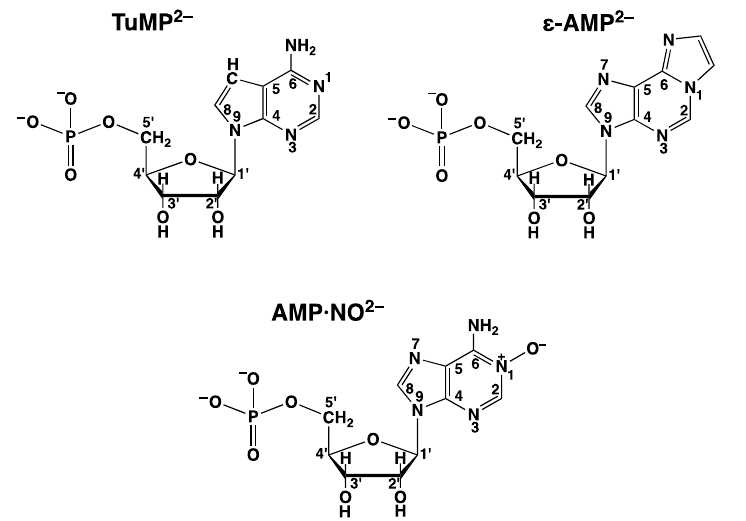
Figure 12. Chemical structures of AMP 2 − analogues: tubercidin 5 ′ -monophosphate (TuMP 2 − = 7-deaza-AMP 2 − ), 1, N 6 -ethenoadenosine 5 ′ -monophosphate ( ε -AMP 2 − ), and adenosine 5 ′ -monophosphate N(1)-oxide (AMP · NO 2 − ).